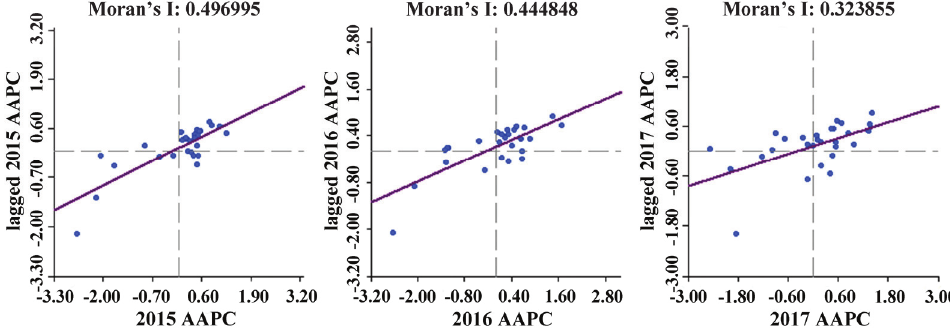
Figure 8. Global Moran’s I scatterplots of AAPC of 28 cities in 2015, 2016, and 2017.